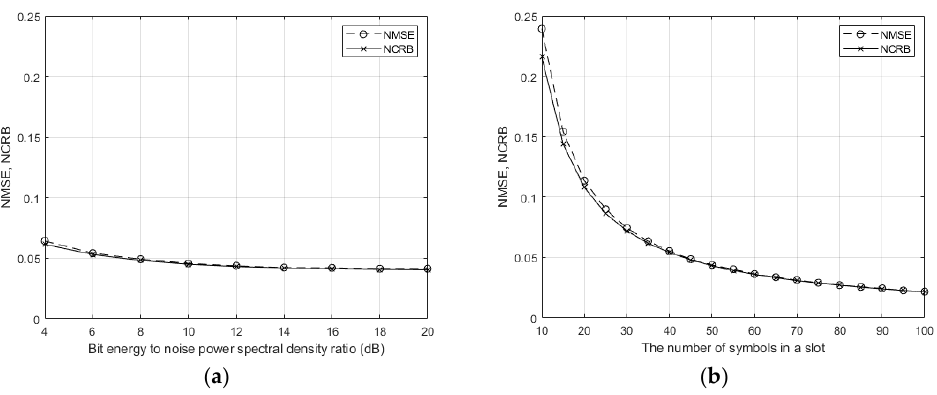
Figure 3. Cramér–Rao bound according to ( a ) bit-energy-to-noise-power spectral-density ratio and ( b ) number of symbols in a slot.